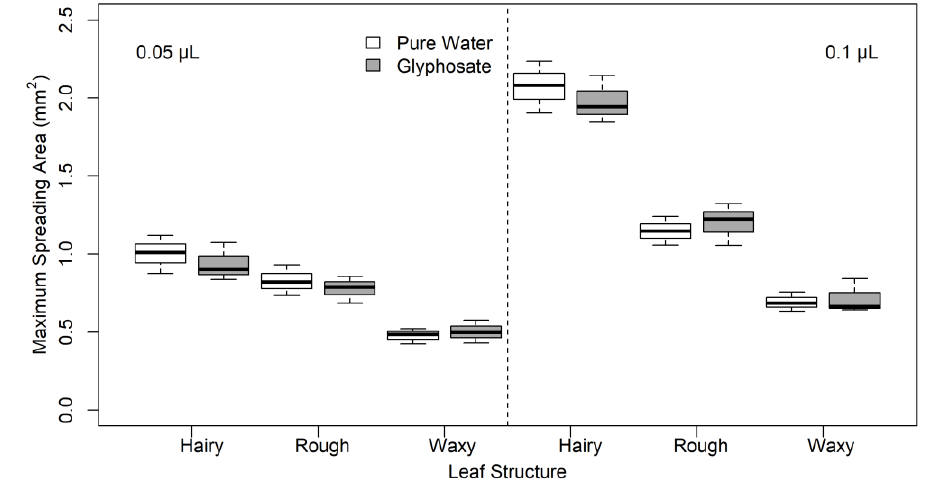
Figure 3. Boxplot of the spreading area of droplets without the surfactant additive on di ff erent leaves and in di ff erent sizes. Spreading results of the droplet with concentrations of 0.05 µ L and 0.1 µ L (left and right side of the dashed line, respectively). The lines in a bar represent the minimum, first quartile, median, third quartile and maximum (from the underside to the upside). For the leaf structure, the group names Hairy, Rough and Waxy represent the leaves of D. sophia, L. temulentum and L. lotifolium respectively .